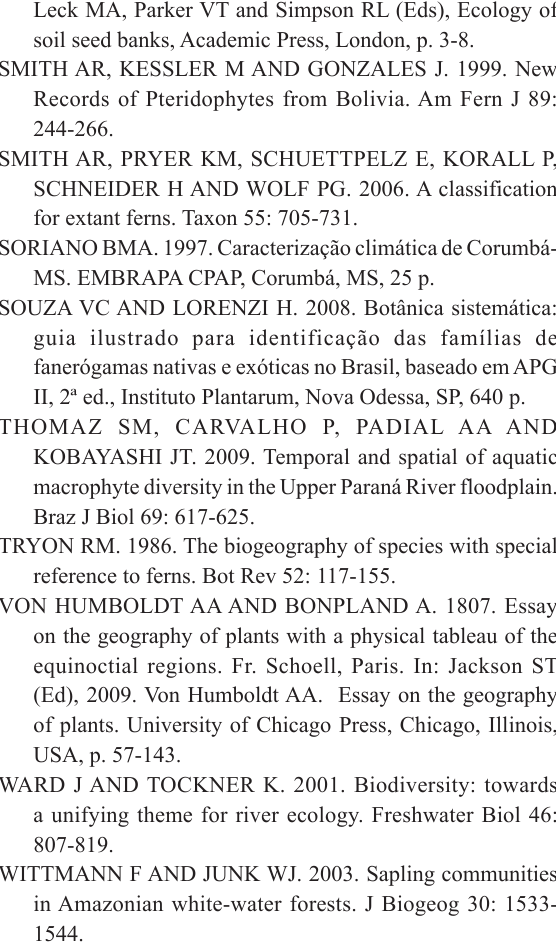
Figure S1 - Maximum and minimum water levels of the Paraguay River in centimeters (cm) at Ladário, Pantanal wetland, from 2000 to 2015. Data provided by the National Institute of Meteorology (INMET-BDMEP). The dashed line shows the level of the Paraguay River in 2010 indicating a low-level inundation when the collections were carried